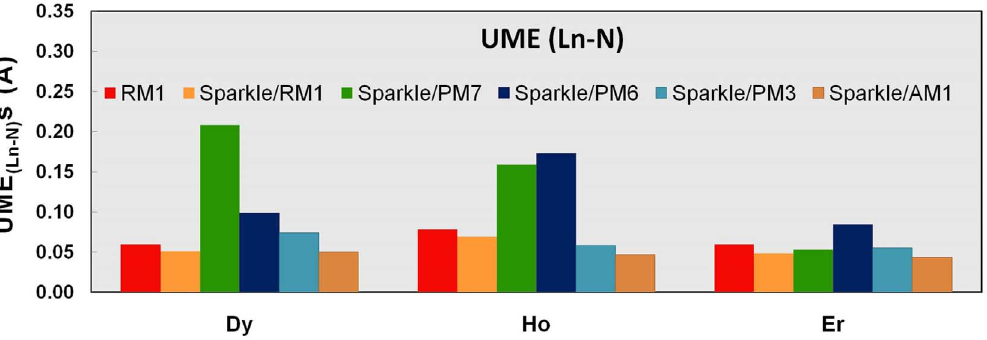
Figure 3. UME (Ln-N) s obtained using the RM1 model for the lanthanides and all five versions of the Sparkle Model: Sparkle/RM1, Sparkle/PM7, Sparkle/PM6, Sparkle/PM3 and Sparkle/AM1 for all complexes of the universe set for each of the lanthanide trications: Dy(III), Ho(III) and Er(III). The UMEs are calculated as the absolute value of the difference between the experimental and calculated Ln- N interatomic distances, summed up for all complexes, for each of the lanthanides.